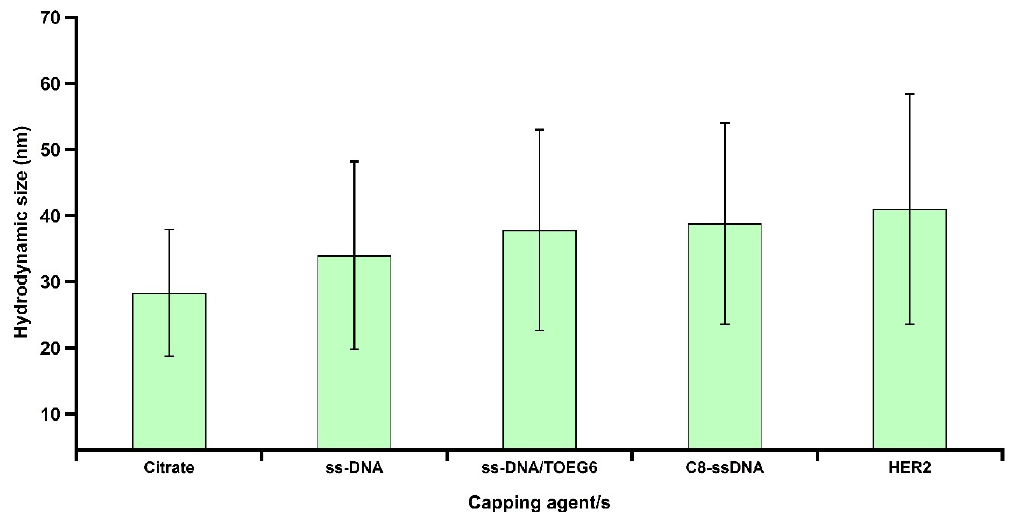
Figure 6. Volume-weighted DLS readouts showed that the resultant HER2 bioconjugation was achieved by the increment of D H size from 38 to 41 nm for C8-terminated AuNPs and HER2@AuNPs, respectively, which can be attributed to the protein recognition.